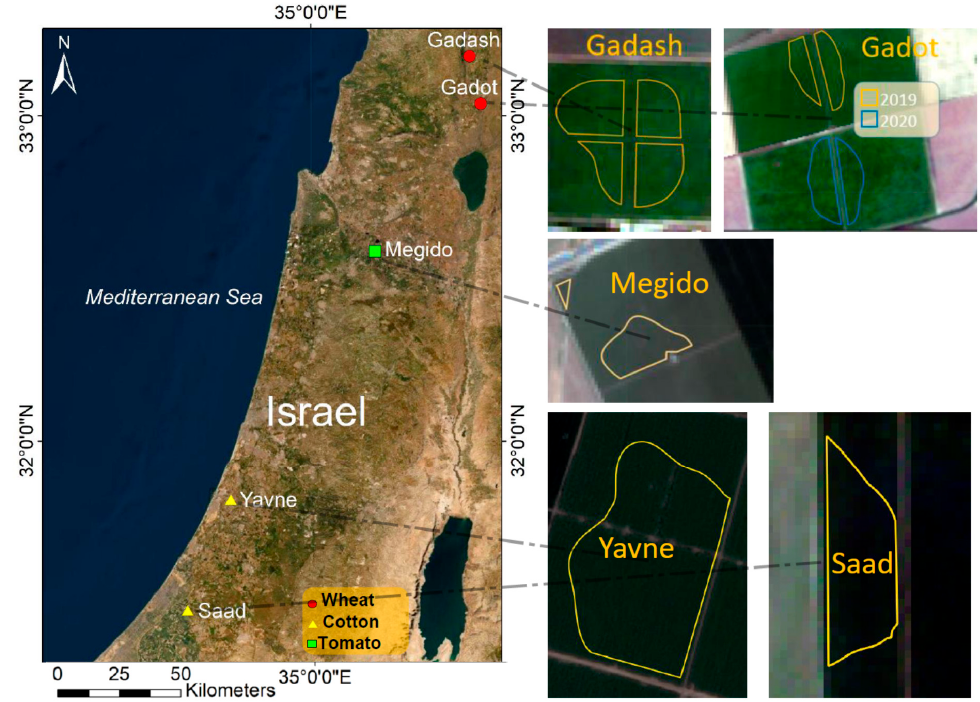
Figure 1. Locations and analysis polygons of the experiments conducted in Israel in 2018–2020. The Sentinel-2 image inventory used for this study is presented in Table 1. Overall, 56 Sentinel-2 images were used in the study (14—wheat, 33—processing tomatoes, 9— cotton). During these experiments, LAI was measured by a SunScan Canopy Analysis System—SS1 developed by Delta-T Company (Cambridge, United Kingdom). The Sun- Scan is a widely used, accurate, nondestructive LAI measurement system successfully em- ployed in many previous studies [5,30,32]. The SunScan system measures LAI by calcu- lating the difference in solar radiance received by the dome sensor installed under unob- scured Sun view and the hand-held probe placed below vegetation canopy on the ground level (Figure 2). Figure 2. Main components of the SunScan system: ( A ) Dome sensor; ( B ) Probe; ( C ) Field com- puter.